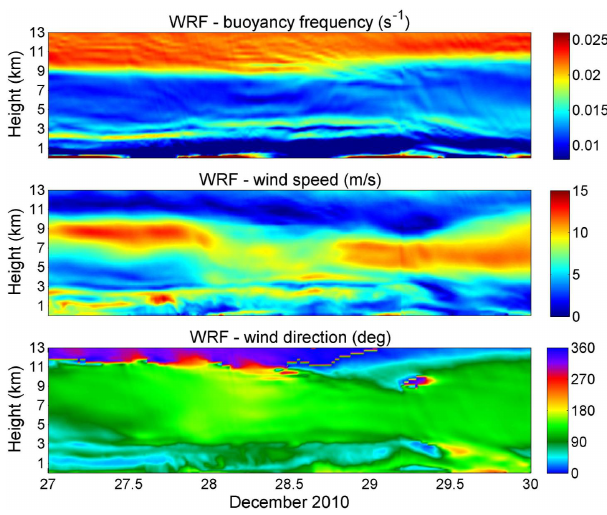
Fig. 6. Time development of buoyancy frequency ( N ) (top), wind speed (ms − 1 ) (middle) and wind direction (deg) (bottom) at the MARA location from the WRF inner domain with 2km horizontal and output data with 10min time